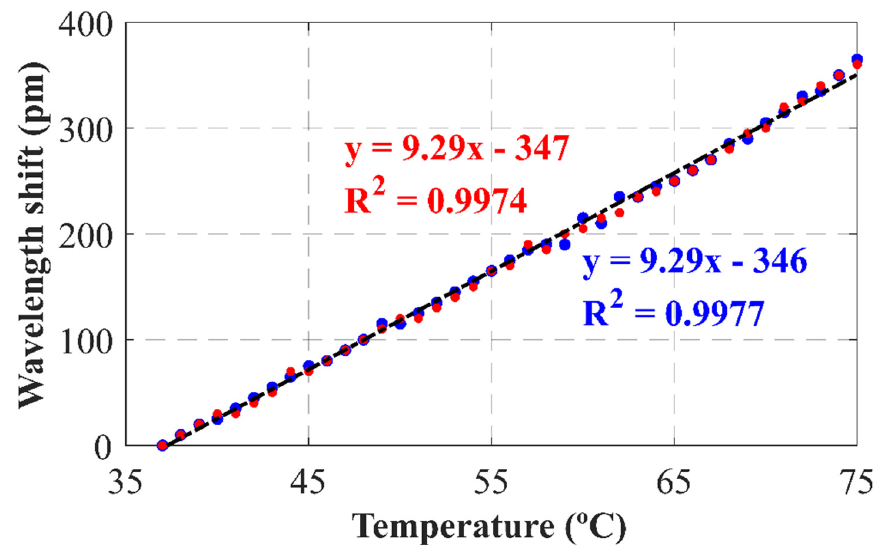
Figure 9. Wavelength shift as function of temperature when using the SMF − RR for the 1527.7 nm (blue) and 1530.81 nm (red) emission lines.